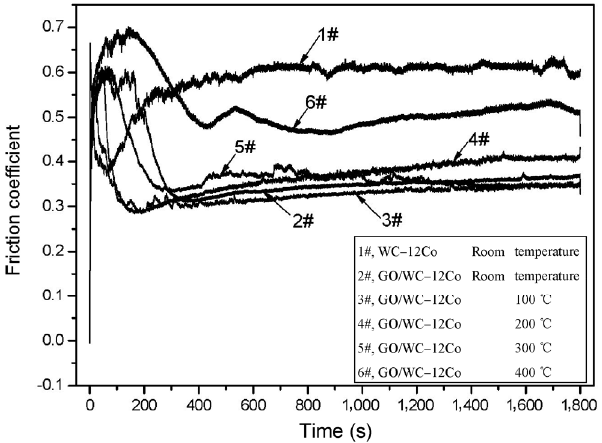
Fig. 12 Friction coefficients of the coatings at high